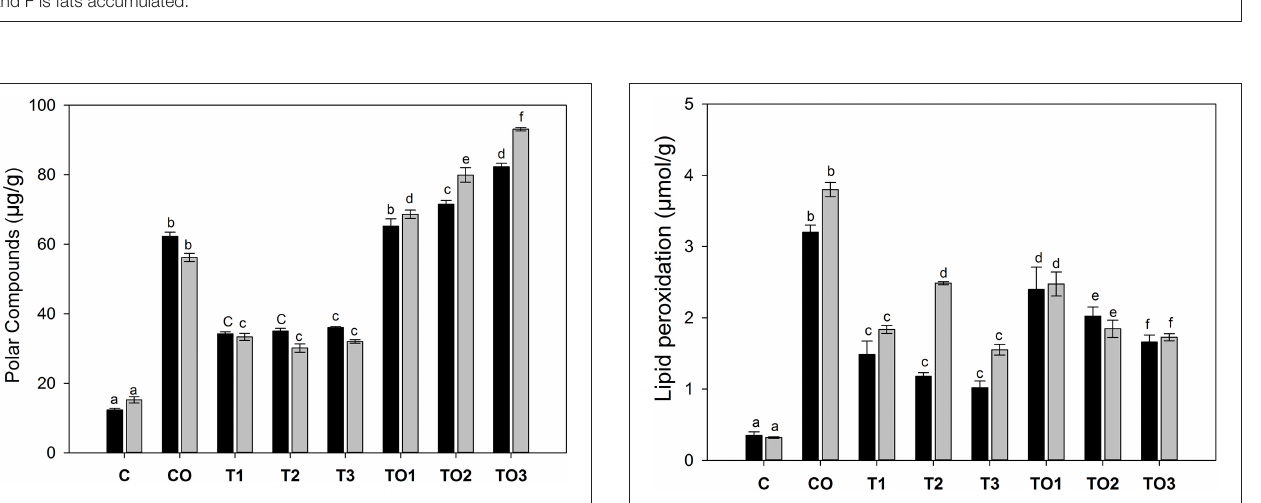
FIGURE 4 | Effects of supplementation of α -tocopherol alone or in combination with oxidized olive oil on the lipid peroxidation in the liver. Different letter (a–f) in the male or female rats represents significance at p < 0.05 ( n = 3). M, F, T, C, and O are abbreviations for male, female, tocopherol, control and oxidized lipids. Statistical comparison was carried out within the same and female group independently. Black bars are male groups, while gray bars are female